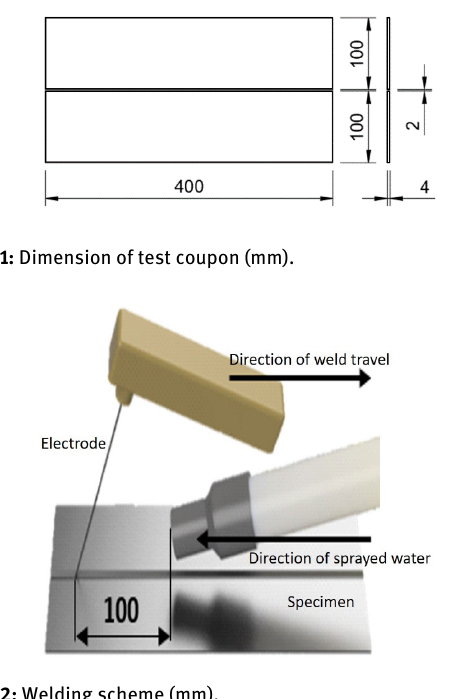
Figure 2: Welding scheme (mm).